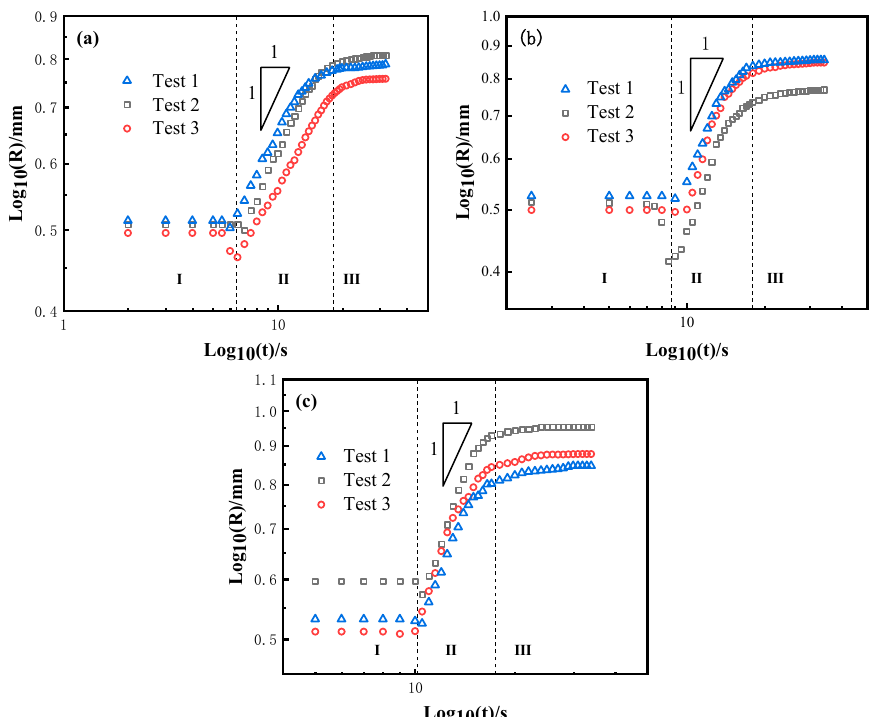
Figure 10. The logarithmic relationship between equivalent expansion radius and time of the BNi2/SLMed TC4 system at: ( a ) 1020 °C; ( b ) 1080 °C, and ( c ) 1150 °C.